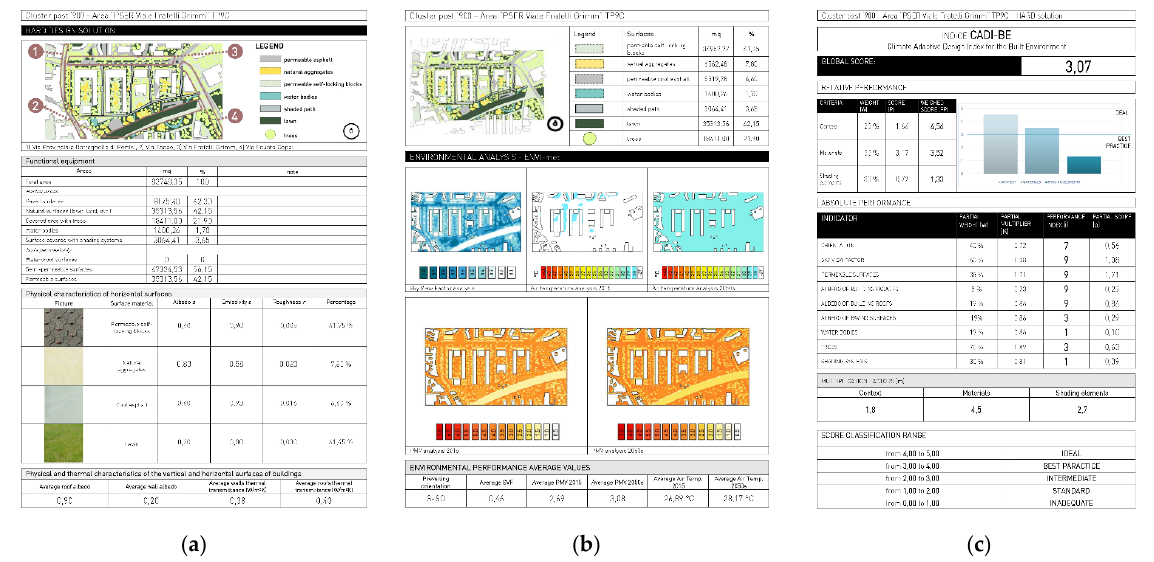
Figure 16. Registration of the TP9C test area with a light meta-design proposal: ( a ) technological analysis; ( b ) environmental analysis; ( c ) CADI-BE output.